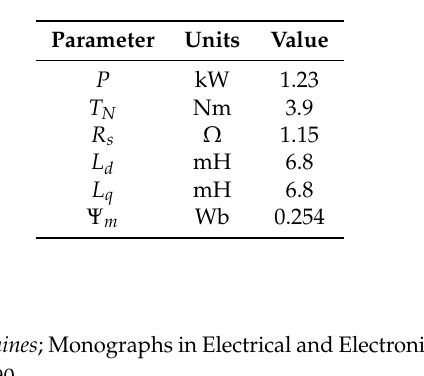
Table A1. Parameters of the